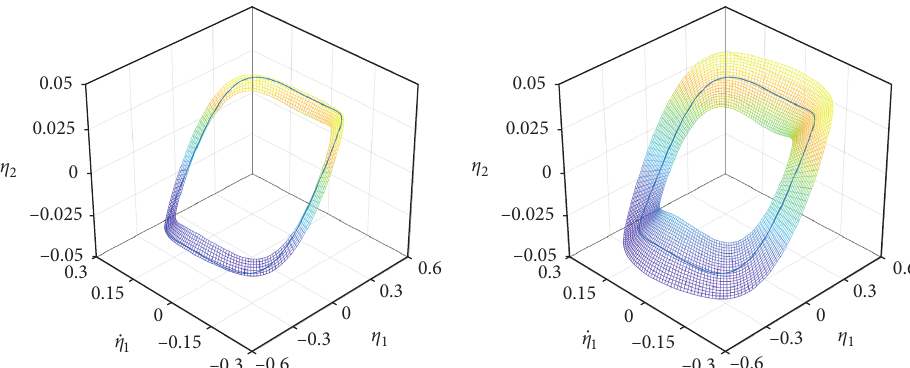
Figure 5: Two approximations of the NNM invariant manifold for the modal displacement constraint η annular domains ( a, ϕ )| a ∈ [ 0 . 41 , 0 . 47 ] , ϕ ∈ [ 0 , 2 π ] 􏼈 􏼉 and ( a, ϕ )| a ∈ [ 0 . 35 , 0 . 55 ] , ϕ ∈ [ 0 , 2 π ] 􏼈 􏼉 in phase subspace. The system parameters are set to the same as in Figure 3. The number of terms for Fourier expansion in equations (9) and (12) is set to be N is divided into 6 or 20 equally sized elements with the number of nodes N a � 7 or N a � 21 to accurately capture the manifold geometry. A representative periodic orbit on the manifold is shown in solid line.